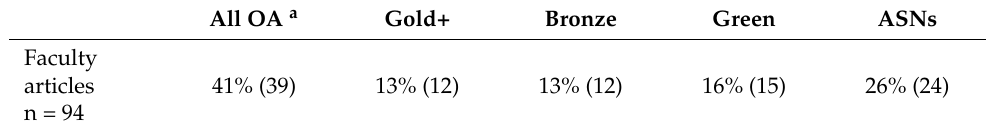
Table 2. Cal State LA Psychology-faculty-authored articles by OA classification. All OA a Gold+ Bronze Green